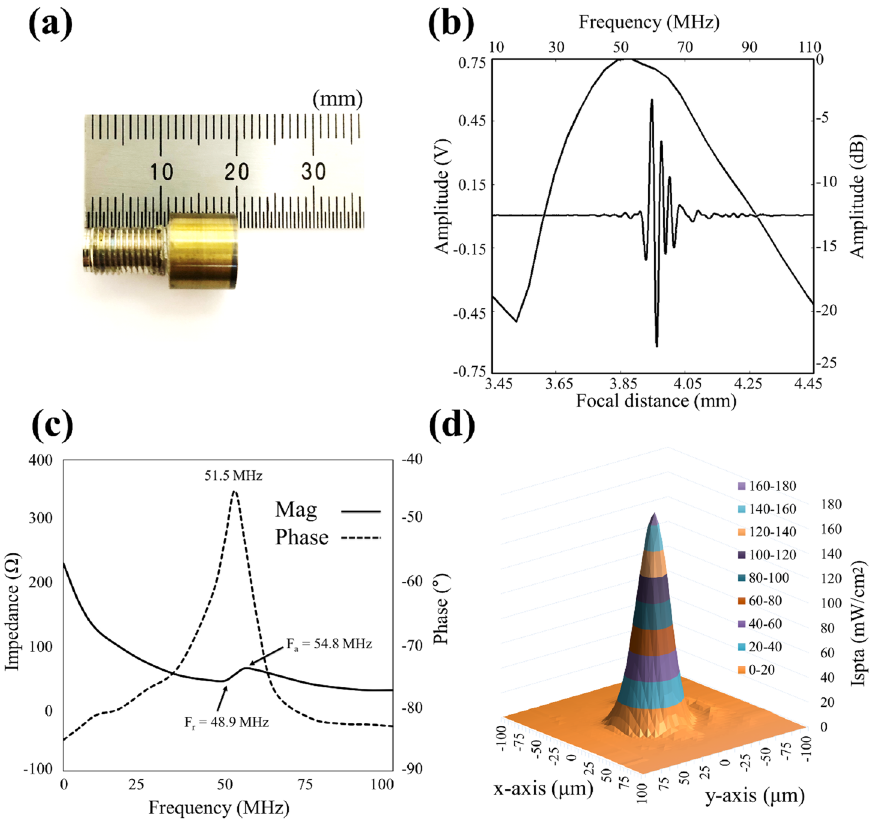
Figure 5. Profile of the home-made ultrasonic transducer ( a ) Photograph of the transducer; ( b ) Pulse-echo response and frequency spectrum; ( c ) The electrical impedance of the transducer (the solid line (the impedance magnitude) and the dotted line (phase angle)); and ( d ) Acoustic intensity field of the ultrasonic transducers. MATLAB R2020a (https:// www. mathw orks. com/ produ cts/ new_ produ cts/ relea se202 0a. html) was used to create ( b , c